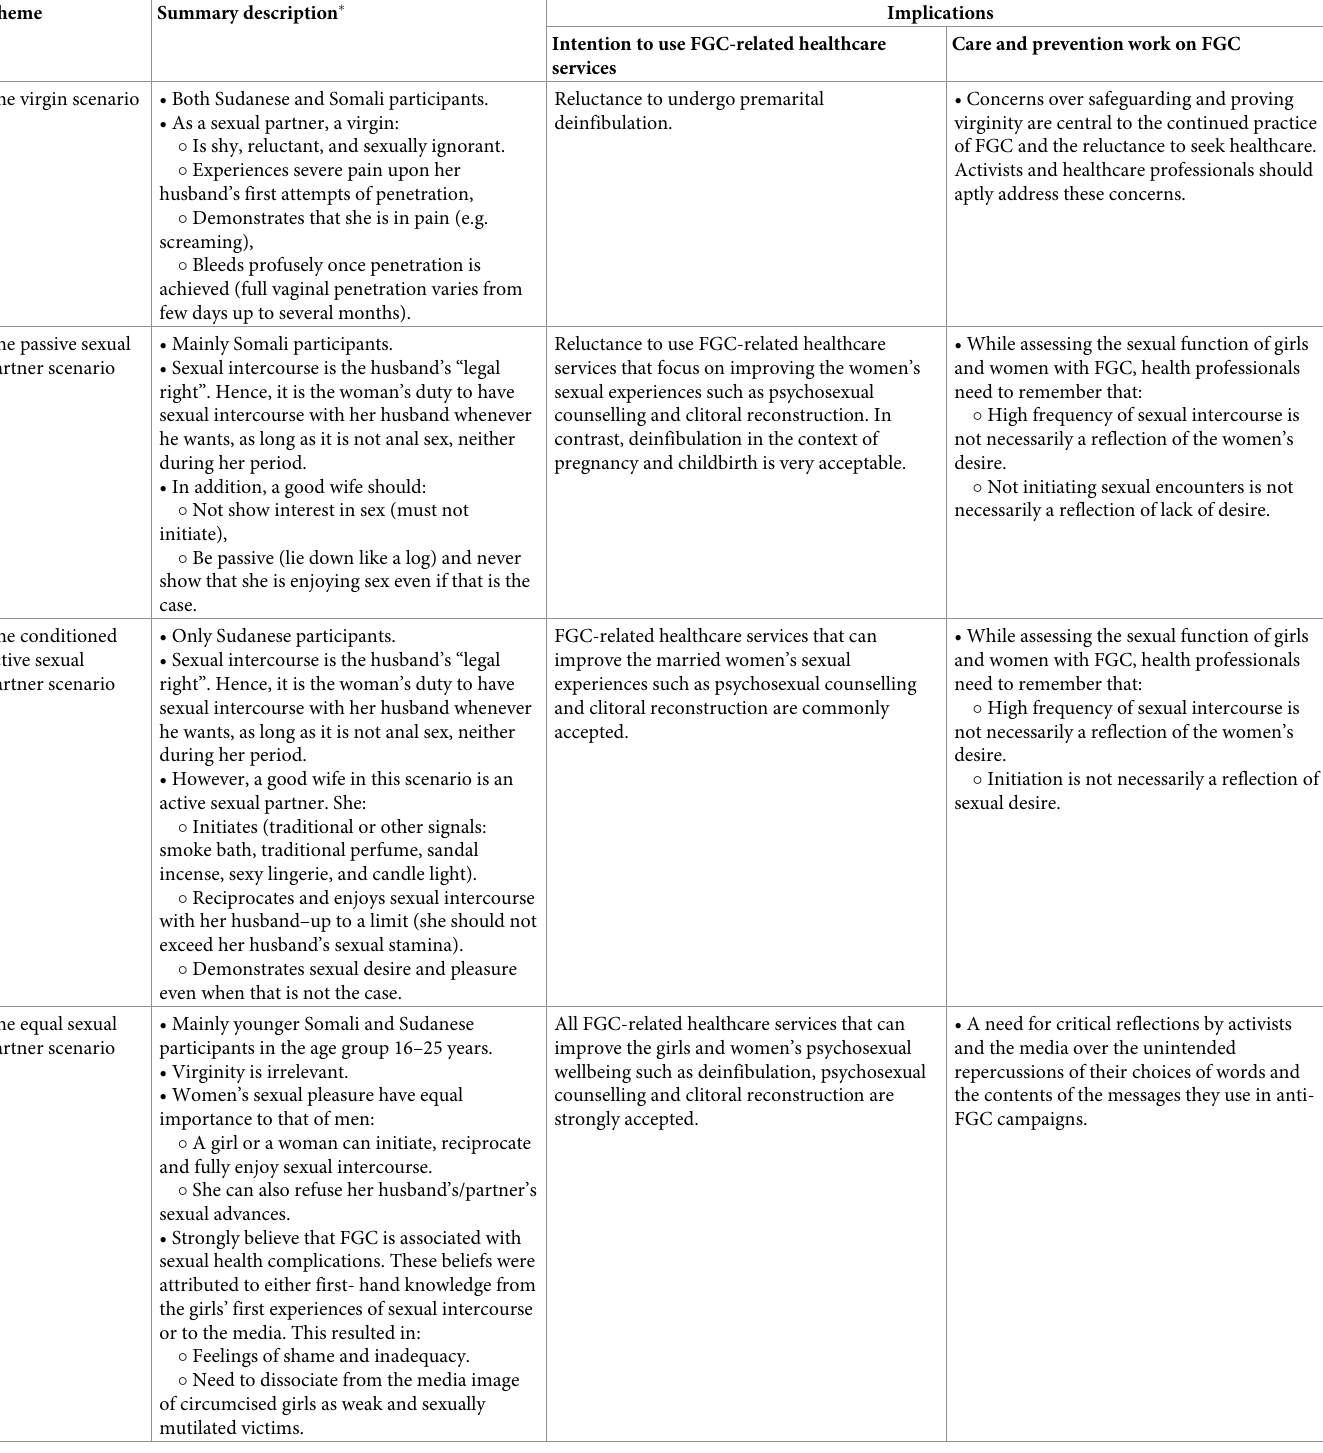
Table 2. Summary description of themes and their implications for the intention to use FGC-related healthcare services and the care and prevention work on FGC.